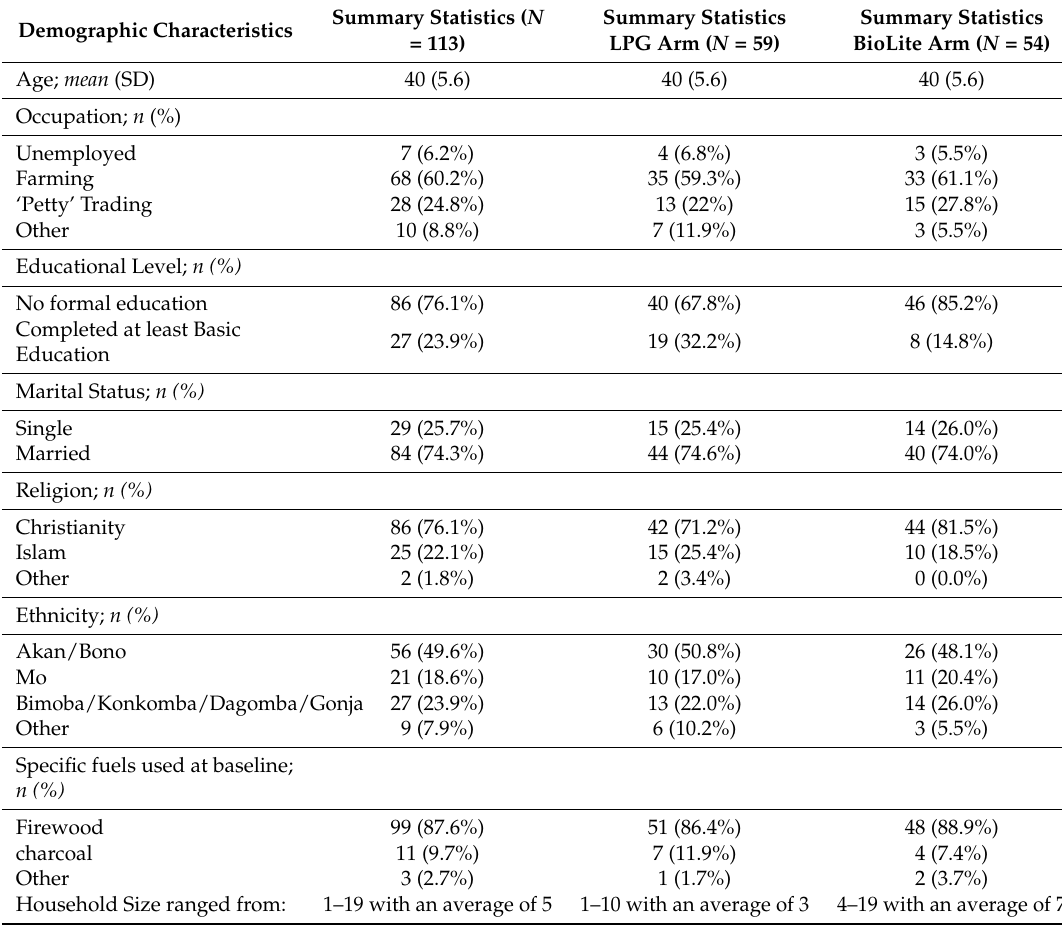
Table 1. Socio-demographic characteristics of